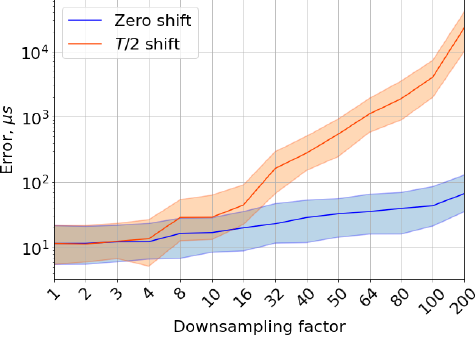
Figure 6. Dependence of error on downsampling factor for 188 Hz cut-off frequency of internal low-pass filter (ILPF), with no additional filtration applied. Two cases of shift between gyroscopes measurements are depicted: zero and half of the sampling period of downsampled data. Bold lines are medians absolute errors; filled areas are interquartile ranges. There is only zero shift for downsampling factor 1 in the graph.